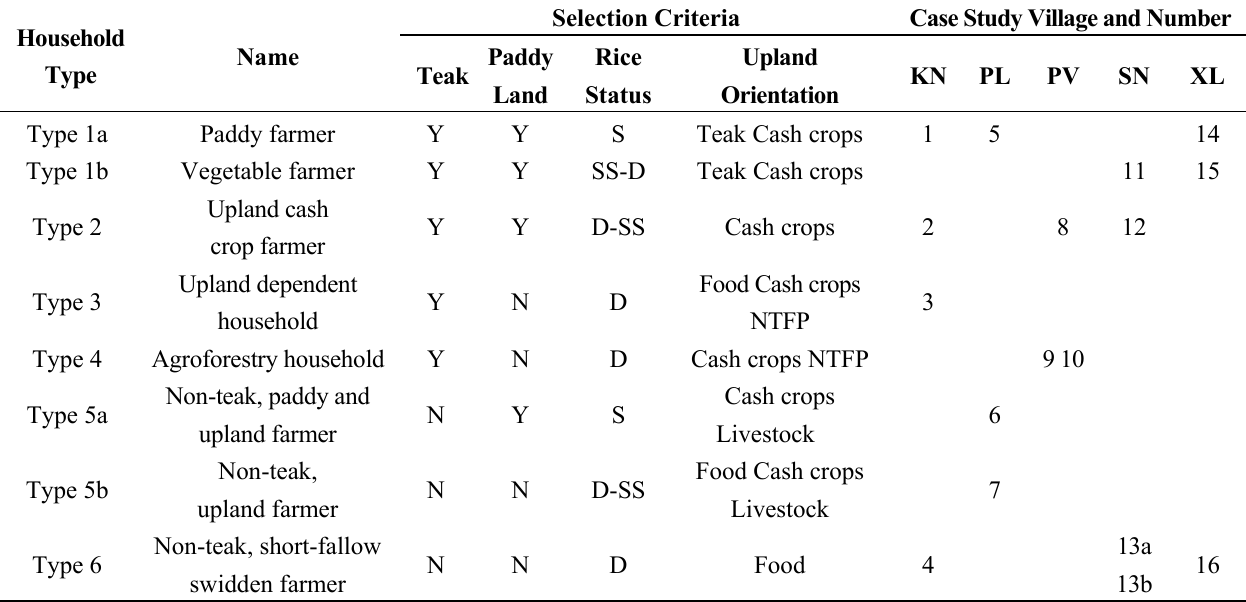
Table 2. Typology of households in case study